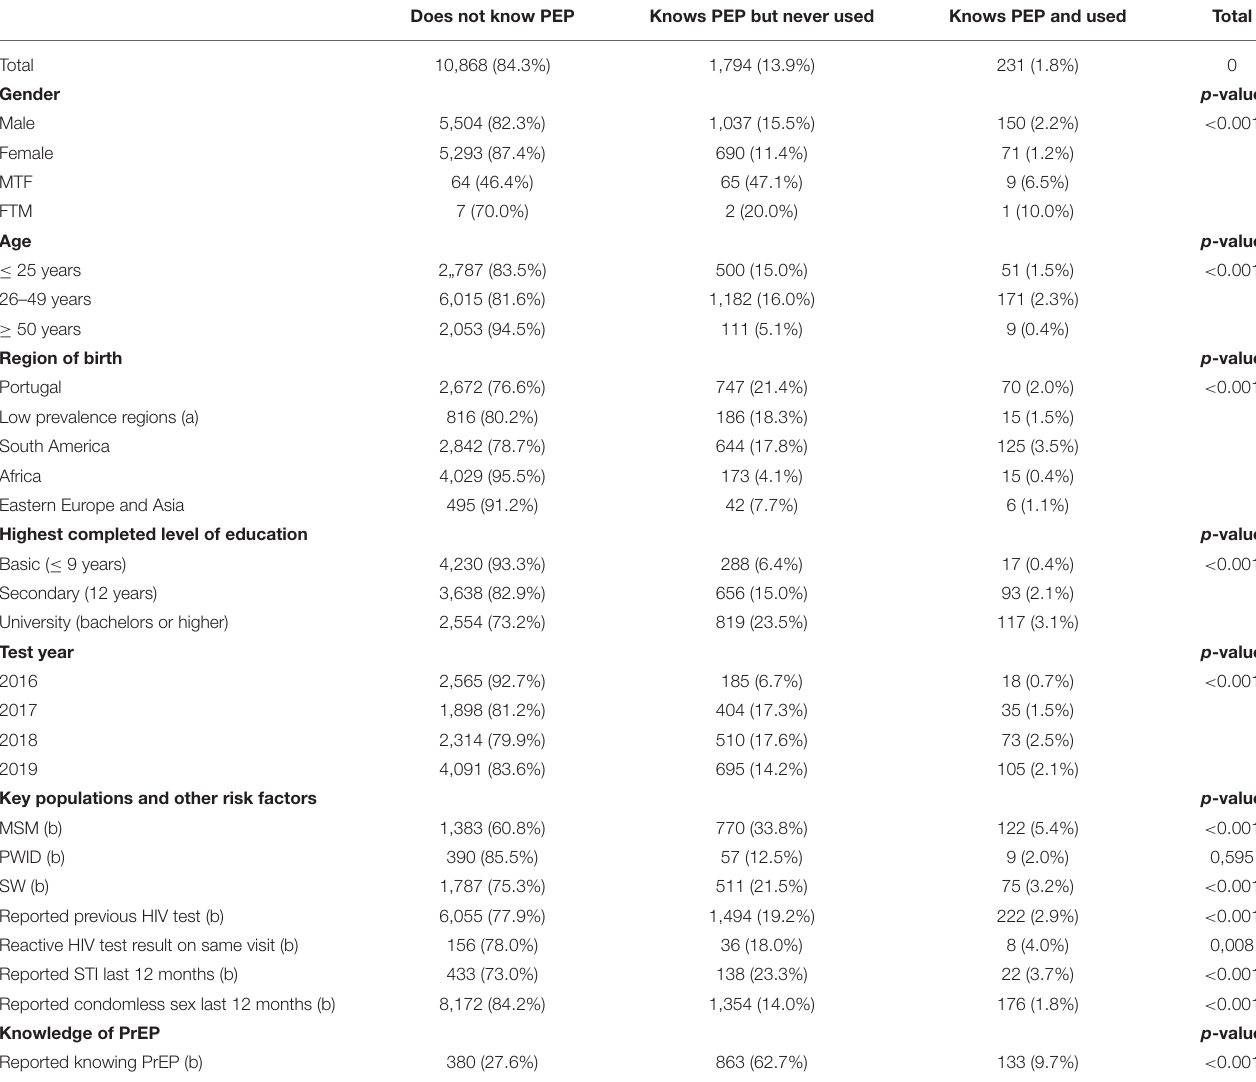
TABLE 1 | Number and percentage of respondents reporting to know